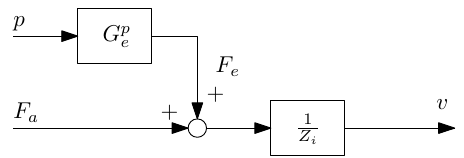
Figure 31. Bock diagram of the two input one output structure (dual SISO).